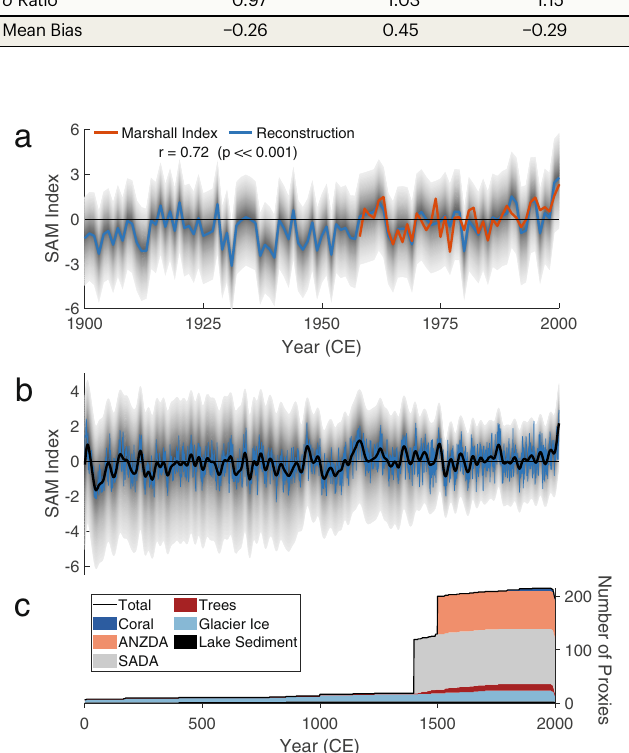
Fig. 2 | Reconstruction evolution over time. a Comparison of the annual recon- struction (blue) with the Marshall index (red) over the instrumental era. Shading indicates the 5 – 95 percentiles of the reconstruction. b Evolution of the annual reconstruction (blue) and 31-year lowpass fi ltered (black) over the Common Era. Shadingindicatesthe5 – 95percentilesofthelowpass fi lteredseries. c Composition of the proxy network over time. Colors for proxy types are as follows: Dark blue (coral), pink (Australia – New Zealand Drought Atlas), gray (South American Drought Atlas), dark red (trees), light blue (glacier ice), black (lake